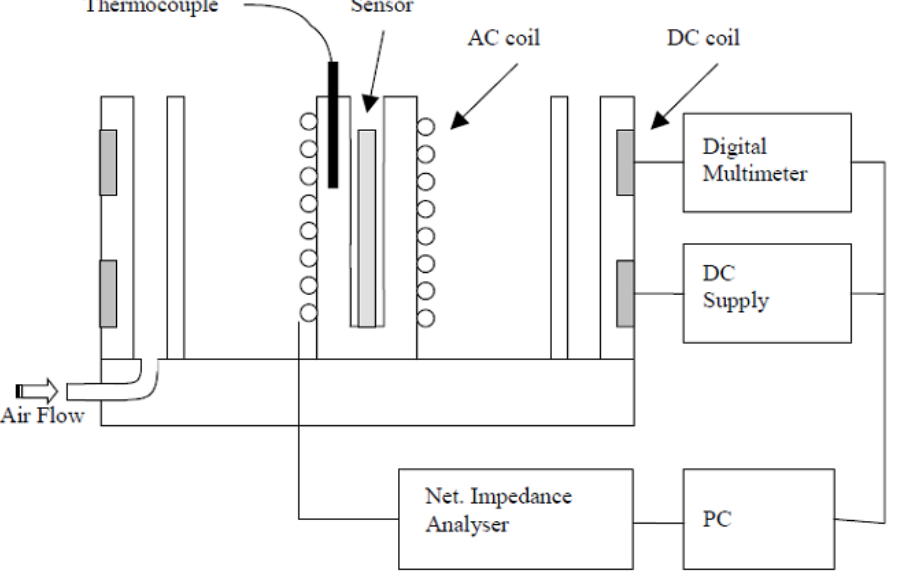
Figure 6. Schematic drawing of common generic components of a magnetoelastic sensing system. Reprinted with permission from